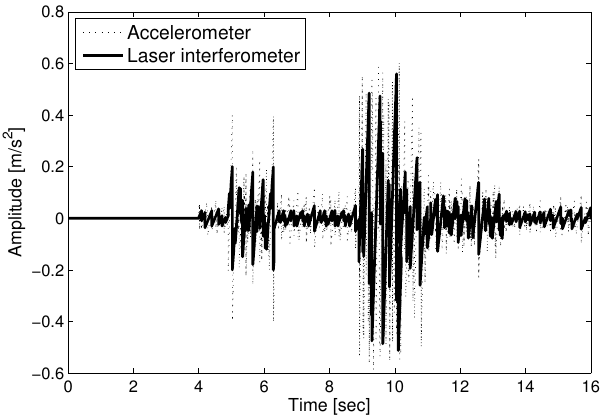
Figure 3. Seismic wave measurement with a laser interferometer.